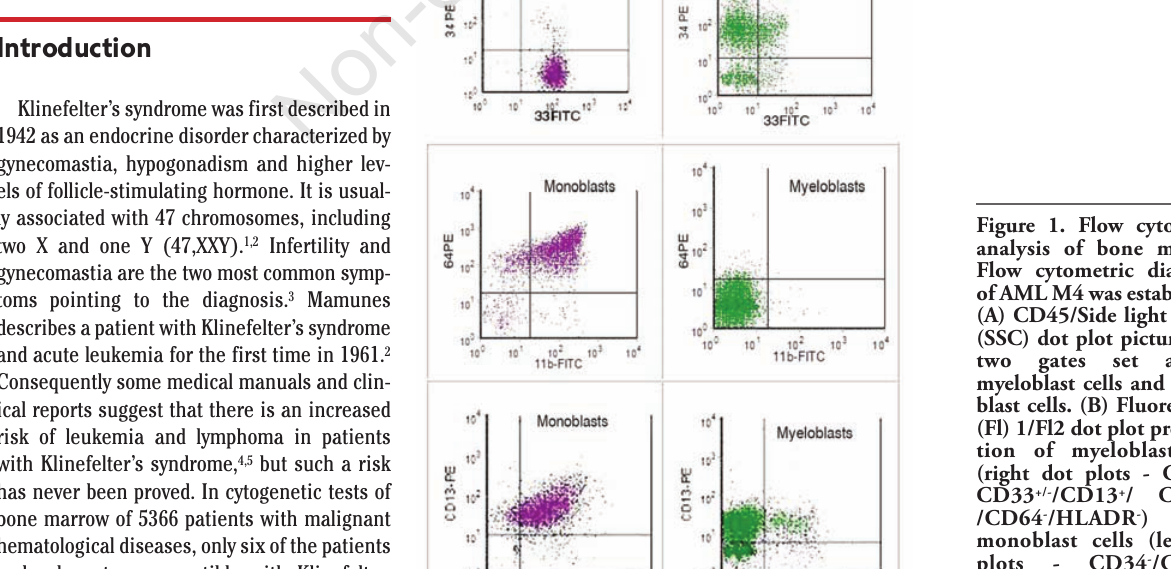
Figure 1. Flow cytometric analysis of bone marrow. Flow cytometric diagnosis of AML M4 was established. (A) CD45/Side light scatter (SSC) dot plot picture with two gates set around myeloblast cells and mono - blast cells. (B) Fluore scence (Fl) 1/Fl2 dot plot presenta- tion of myeloblast cells (right dot plots - CD34 + / CD33 +/- /CD13 + / CD11b - /CD64 - /HLADR - ) and monoblast cells (left dot plots - CD34 - /CD33 + / CD13 + /CD11b + /CD64 + /H LADR +